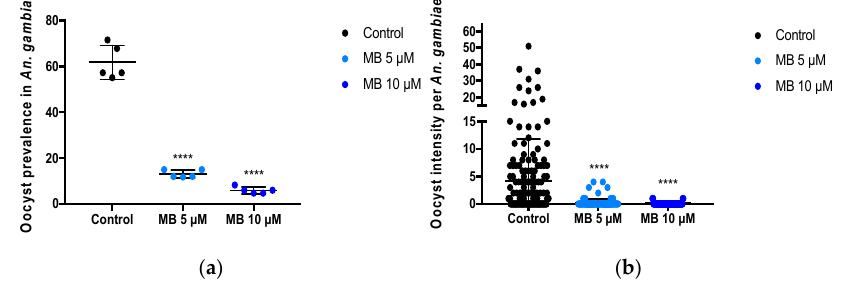
Figure 1. MB inhibits P. falciparum transmission in An. gambiae . ( a ) Prevalence of the infection is presented as the percentage of infected mosquitoes as measured by the presence of oocysts. ( b ) The infection intensity is presented as the number of oocysts per single midgut (black dots). The black lines represent the mean and standard deviation. Data from 5 independent experiments are presented in A–B, corresponding to five different isolates. **** p = 0.0001 when compared to control by t -test.